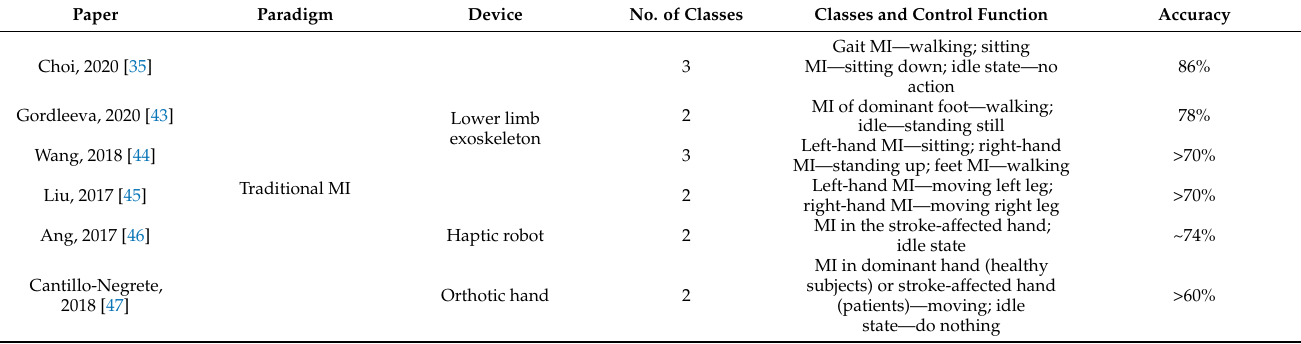
Table 1. A summary of EEG paradigms, devices, and control functions in the literature for single- paradigm